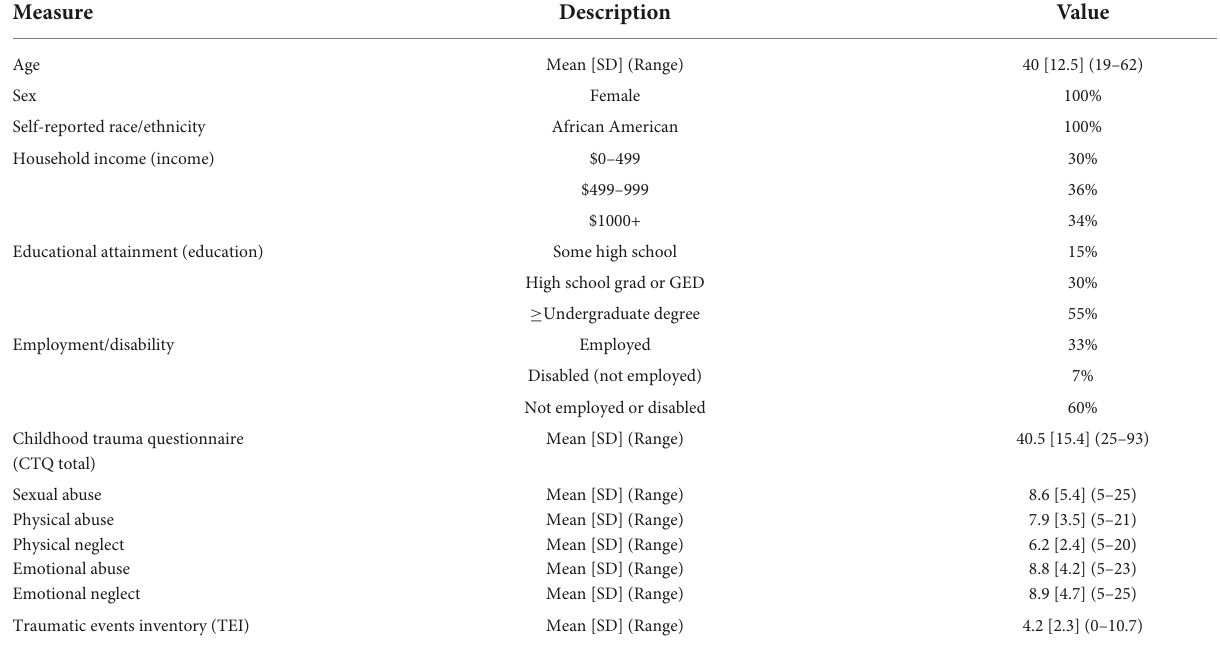
TABLE 1 Demographic and psychosocial measure summary statistics (non-scaled) for the current sample ( n = 97).